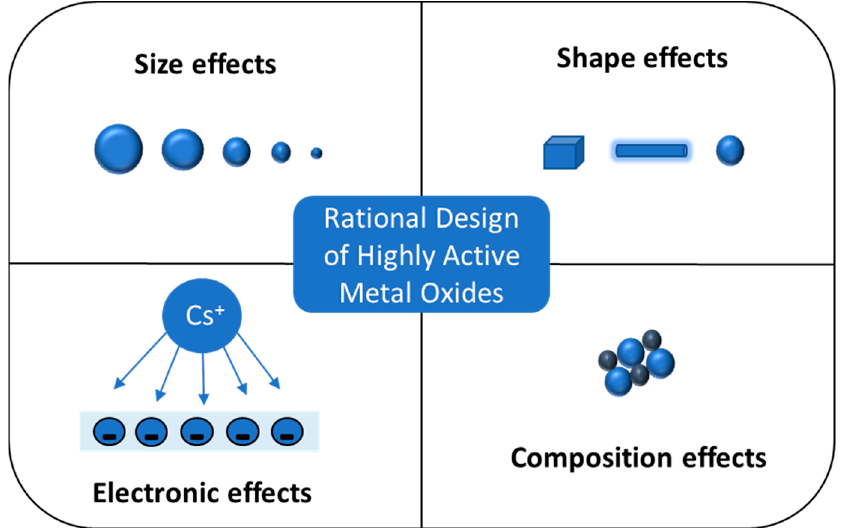
Figure 11. Representative scheme of the parameters affecting the catalytic behavior of metal oxides (MOs) in the CO 2 hydrogenation process: size, shape, composition, and electronic/chemical state. Adapted from ref. [271] , open access, Catalysts 2020.